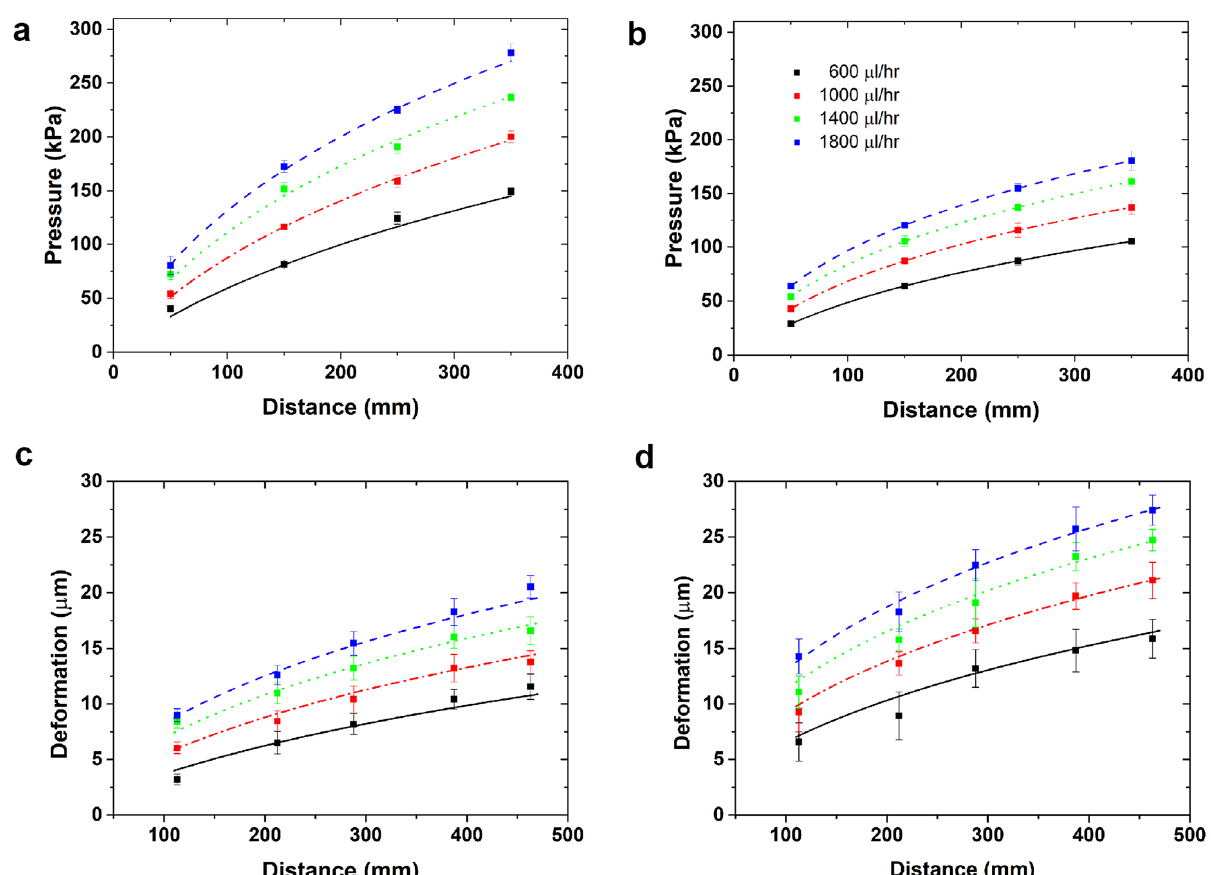
μ l/h, respectively. Deformation of channel height as a function of distance from the outlet along the microchannel c before soaking and d after, measured using confocal microscopy with solid lines of theoretical values from Eq. 3 using Young’s modulus values previ- ously